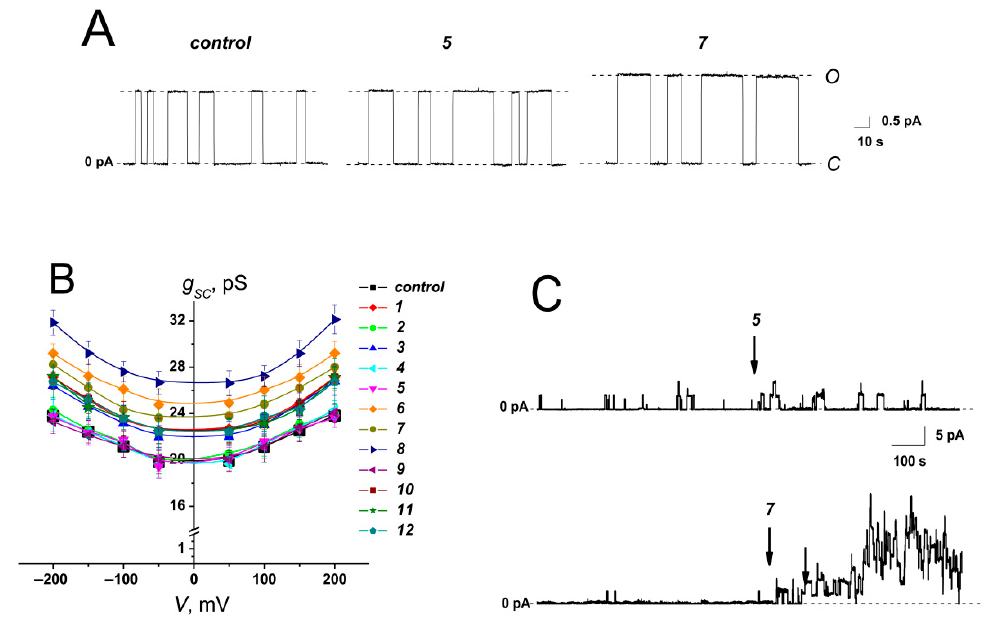
Figure 2. ( A ) Current fluctuations corresponding to opening and closing single gramicidin A channels in the absence ( control ) and presence of 5 and 7 at 100 µg/mL. V = 150 mV. C —closed state of the channel, O —open state of the channel. ( B ) g sc ( V ) curves of single gramicidin A channels in the absence and presence of chromone-containing allylmorpholines at 100 µg/mL. The relationship between the color of the symbol and the compound is given in the figure legend. ( С ) The effects of 5 and 7 on pore-forming activity of gramicidin A. A peptide was added into the bathing solution at both sides of the bilayers up to 1 nM. The moments when up to 100 µg/mL of 5 ( upper panel ) and 7 ( lower panel ) was added in the bilayer bathing solution are indicated by arrows. The membranes were composed of POPC and bathed in 2.0 M KCl (pH 7.4). V = 150 mV.